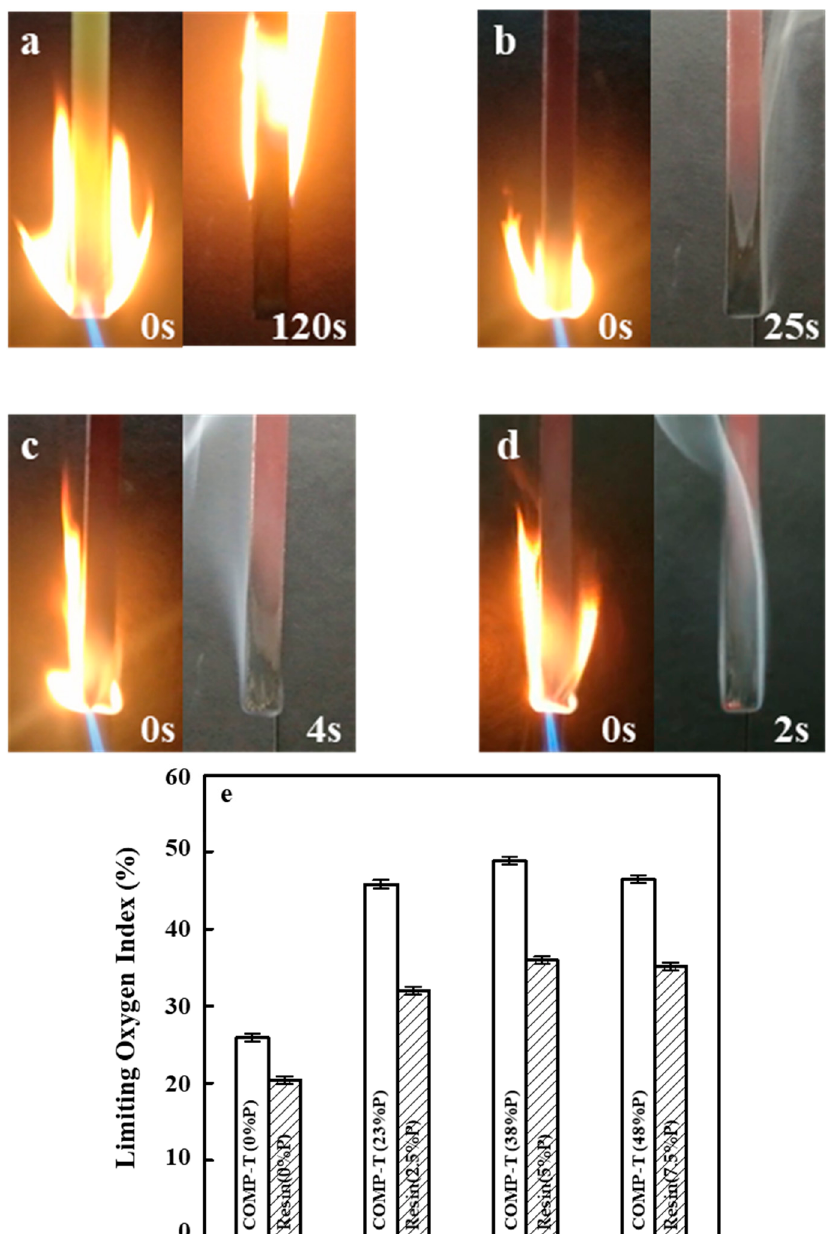
Figure 5. Digital pictures taken during the first burning of RTM epoxy composites preformed by ET3228 tackifiers containing ( a ) 0, ( b ) 23, ( c ) 38, and ( d ) 48 wt.% MRP, where the time was counted after the sample had been ignited for 10 s. ( e ) Limiting oxygen index (LOI) values for the RTM composite samples preformed by the ET3228 tackifiers containing 0, 23, 38, and 48 wt.% MRP (white columns), and the cured EP3228 resin samples containing 0, 2.5, 5, and 7.5 wt.% MRP (gray columns). All the t-tests carried out on the LOI values of the composites and cured resins resulted in a p value less than 0.001, indicating that the dependences of LOI value on MRP content for the composites and cured resins are statistically significant.